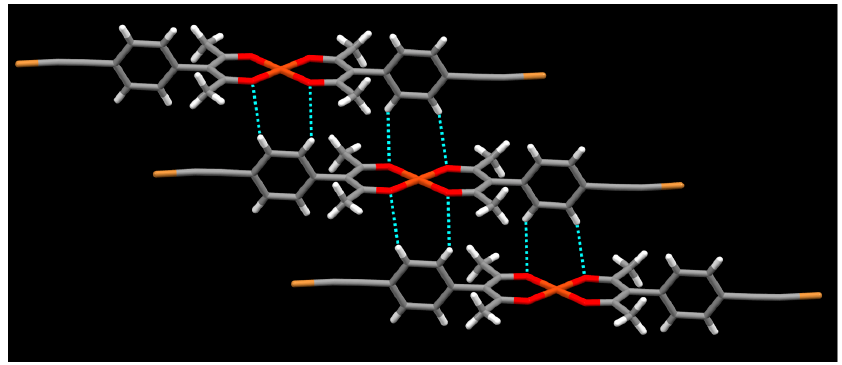
Figure 9. A stack of complex ions in the structure of [Cu( L2 ) 2 ]·2C 4 H 8 O 2 (solvent molecules are omitted, color codes: red—oxygen; gold—bromine; orange—copper).